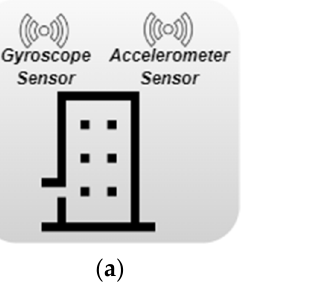
Figure 5. User’s surrounding environments ( a ) at 𝑡 0 and ( b ) at 𝑡 1 .